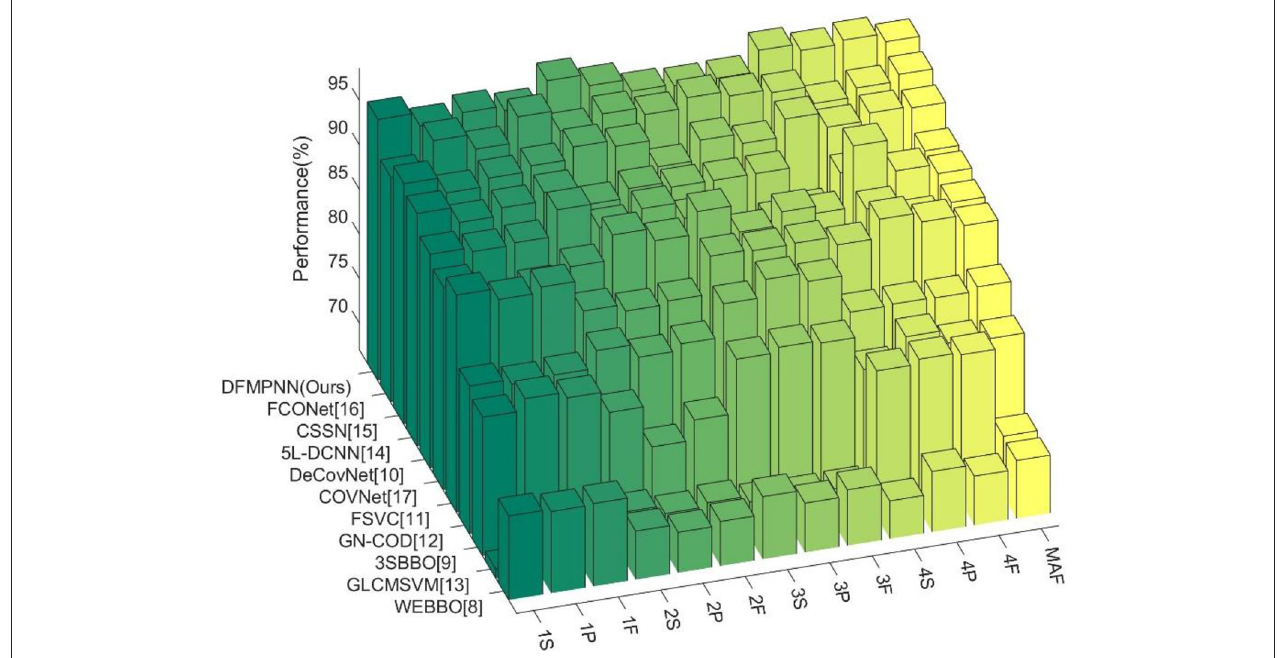
FIGURE 12 | A 3D bar plot of algorithm